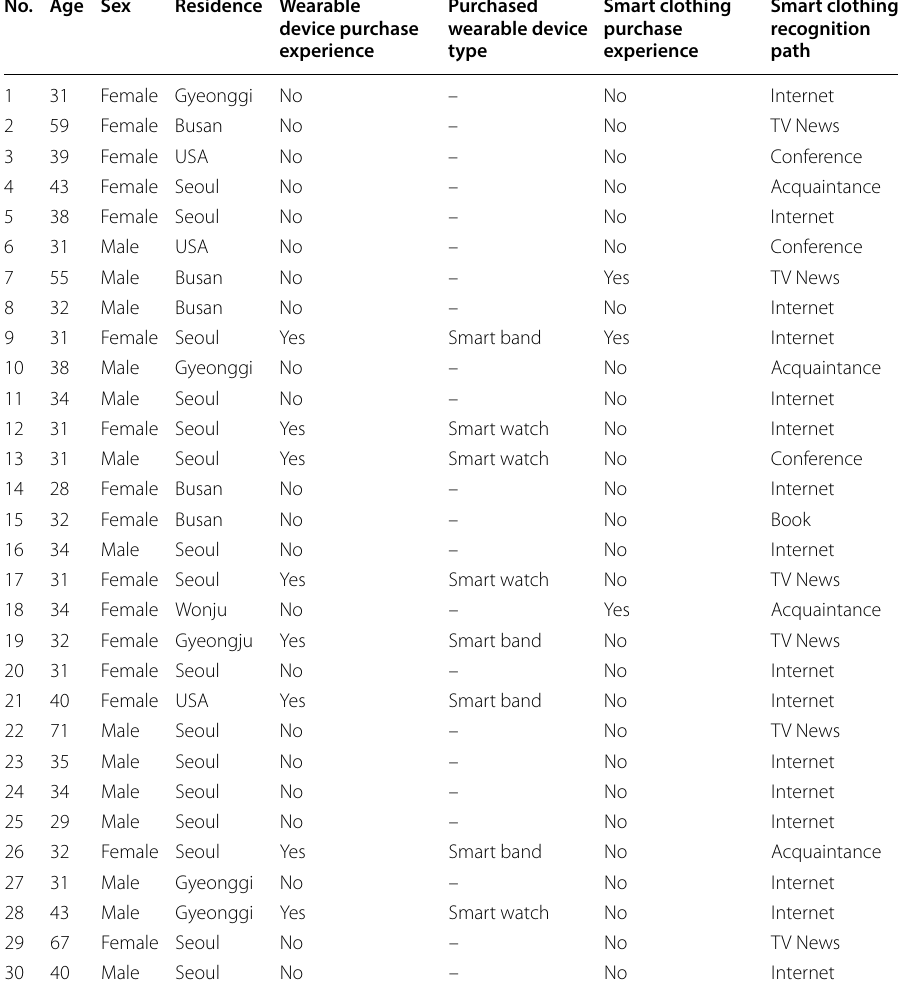
Table 1 Characteristics of respondents No. Age Sex